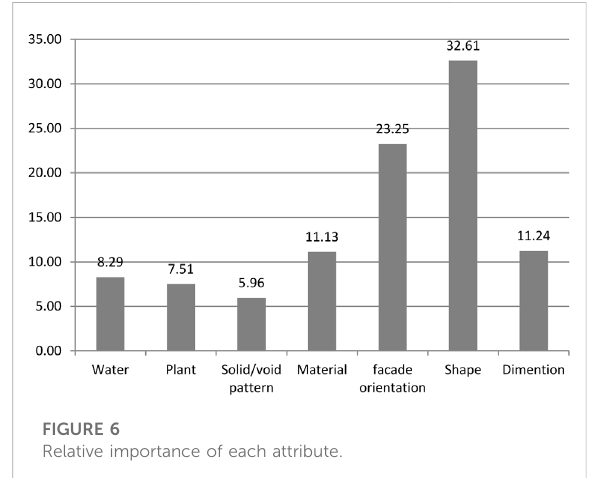
FIGURE 6 Relative importance of each attribute.